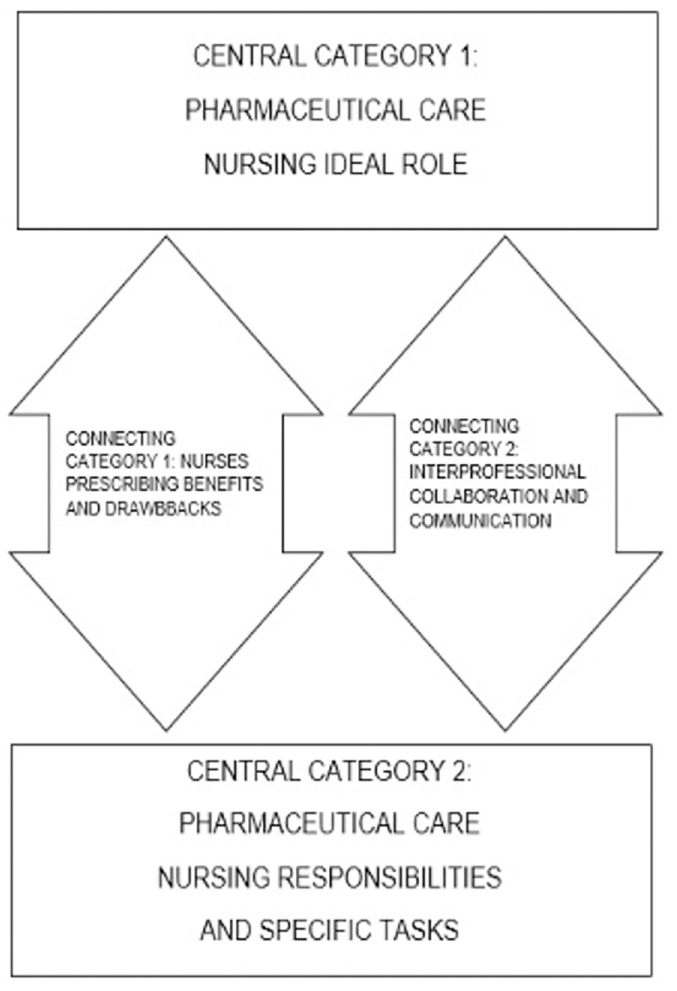
Fig 1. Comprehensive model about pharmaceutical care in